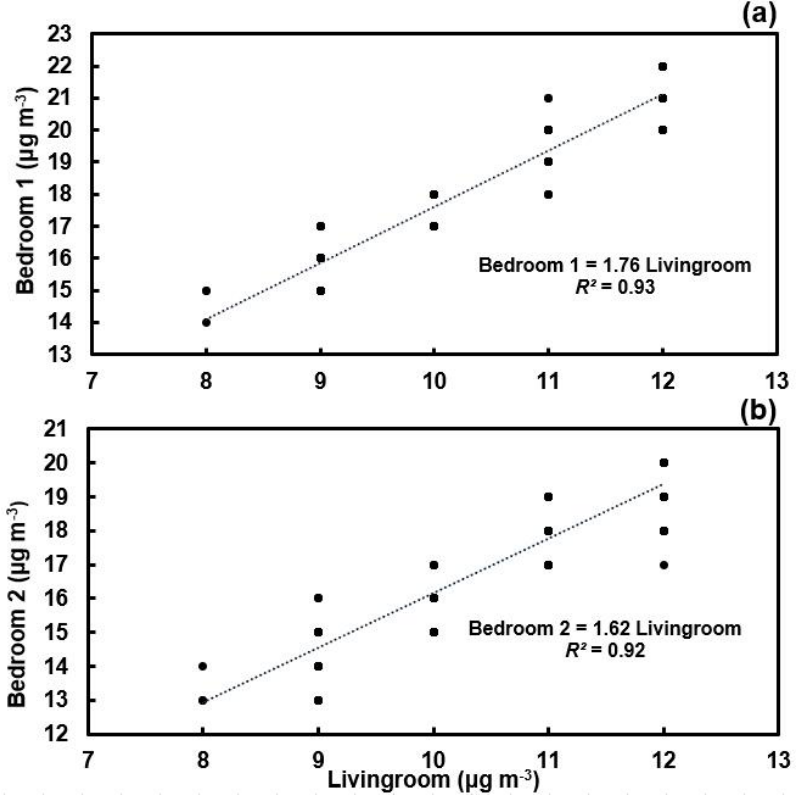
Figure 2. Calibration between fine particulate matter (PM 2.5 ) monitor in living room and bedroom 1 ( a ) and in living room and bedroom 2 ( b ). ( a ) and in living room and bedroom 2 ( b